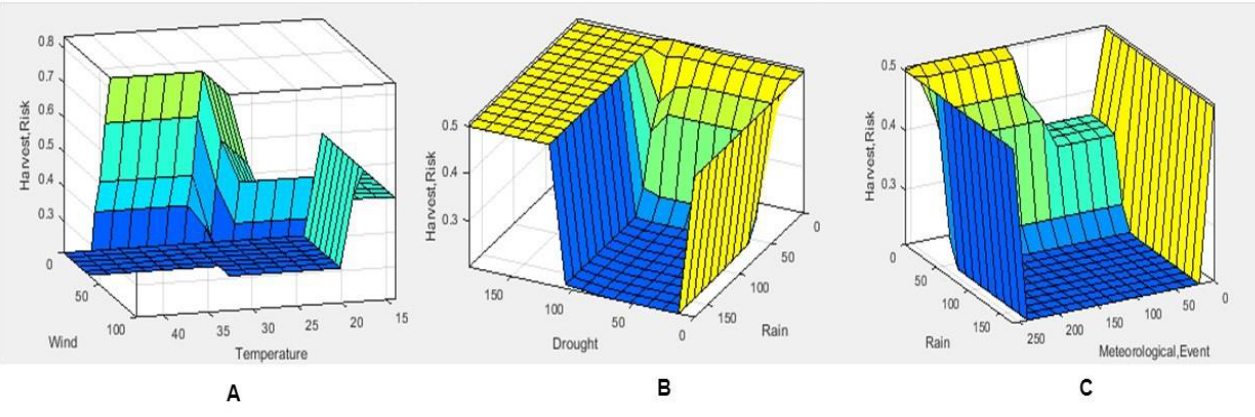
Figure 9. Impact of input variables in uncertain parameters model .